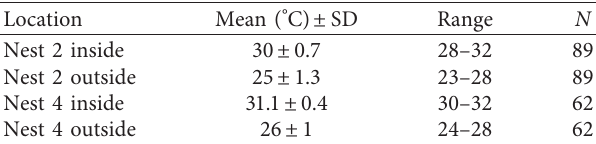
Table 2: Comparative ranges, means, and respective standard deviations for outside and inside temperature ( ° C) dynamics of